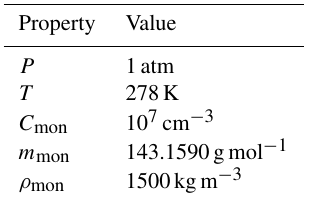
Table 1. Temperature ( T ), ambient pressure ( P ), vapor monomer concentration ( C mon ), vapor monomer mass ( m mon ), and vapor monomer density ( ρ mon ) used in Atmospheric Cluster Dynamics Code simulations in this